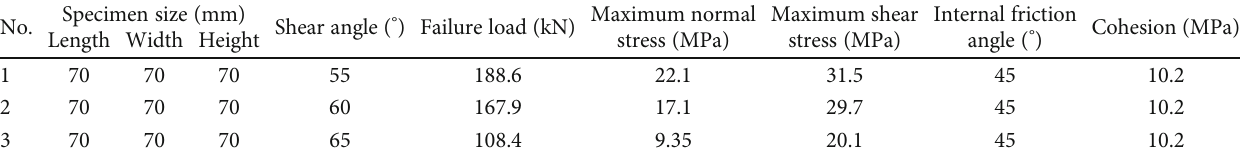
Table 9: Shear strength test.